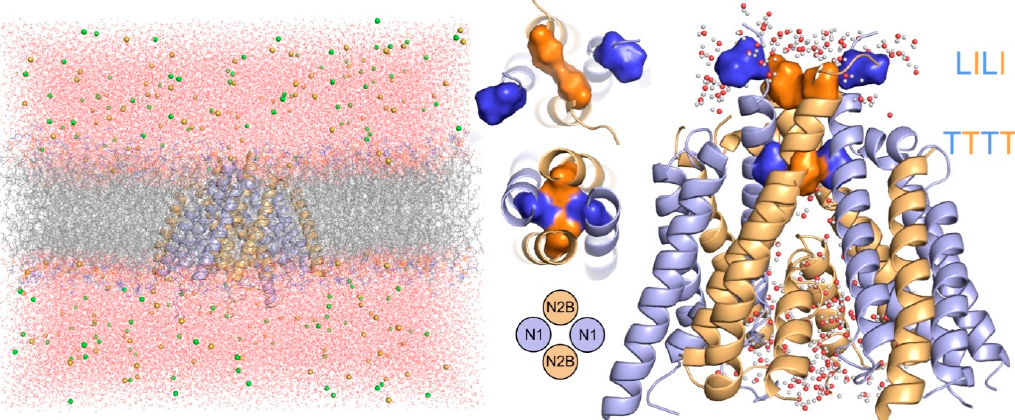
Figure 2. Summary of the explicit solvation all-atom molecular dynamics (MD) simulation of the transmembrane domain of the NMDAR in the RAA state. ( Left ) Snapshot from the 100 ns MD simulation showing the TMD in blue/orange cartoon for the GluN1/GluN2B subunit, anchored in a DOPC membrane (grey/red/blue for carbon/oxygen/nitrogen atoms), and surrounded by water and ions in a simulation box. ( Middle ) Top view of the channel-lining M3 helices. The gating residues of the auxiliary LILI gate formed by Leu657 of GluN1 (blue) and Ile655 of GluN2B (orange) were located above the TTTT gate formed by Thr648 of GluN1 and Thr647 of GluN2B. ( Right ) Zoom of the TMD showing water molecules above and below the gating residues of the auxiliary LILI gate on top of the TTTT gate. During the course of the simulation, there were no water molecules or ions found in the confined space between the LILI and TTTT gates, supporting the impermeability of the channel in the RAA state based on the Thr–Thr